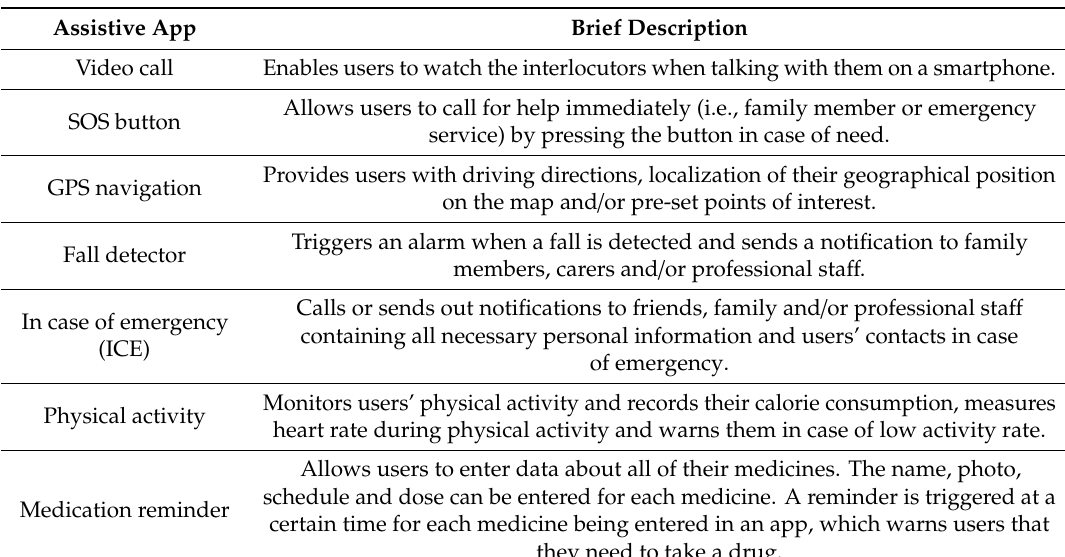
Table A1. Description of assistive apps on